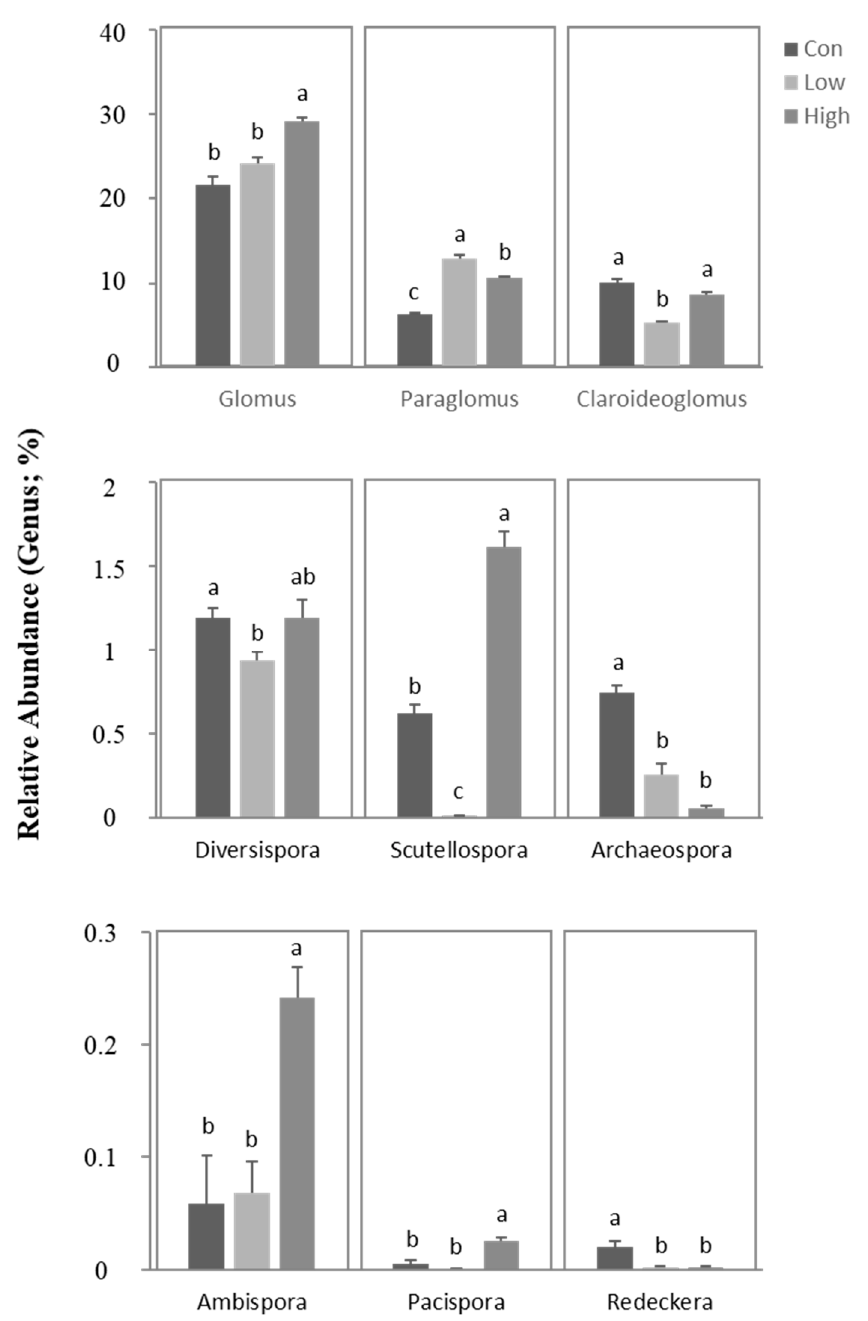
Figure 3. Relative abundance of the AMF community composition in rhizospheric soil at the genus level. Con—no treatment (control); Low—biogas slurry (250 m 3 ha − 1 yr − 1 ) treatment; High—biogas slurry (375 m 3 ha − 1 yr − 1 ) treatment. Error bars represent the standard errors of three replications. Different lowercase letters indicate significant ( p < 0.05) differences between the treatments.